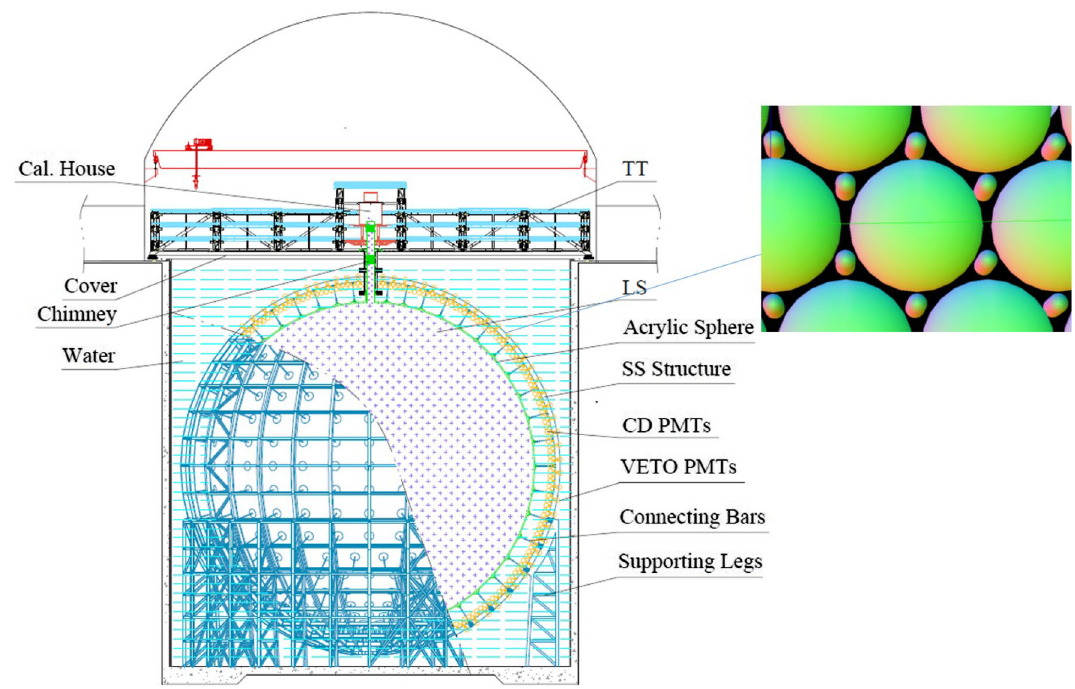
Fig. 1 Layout of the JUNO detector system [8]. The zoomed in picture on the right is illustrating the proposed PMT arrangement of the JUNO central detector, with the 3-inch PMTs placed in the gaps between the 20-inch